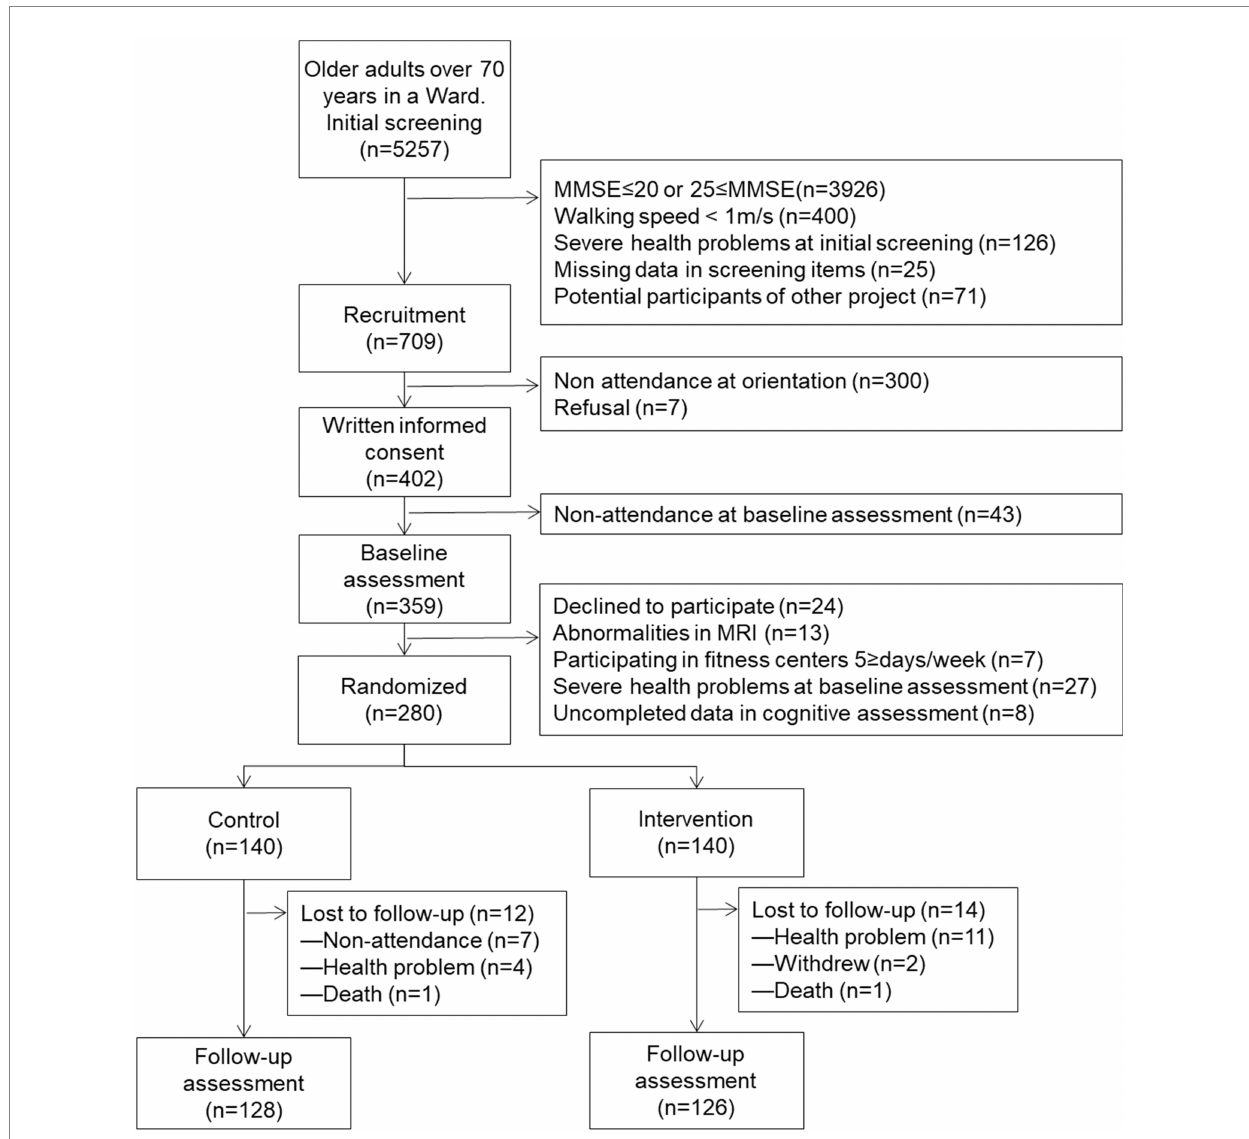
FIGURE 1 Flow diagram of the participants in the community-based lifestyle intervention program from the screening to the final follow-up assessment. MMSE, mini-mental state examination; MRI, magnetic resonance